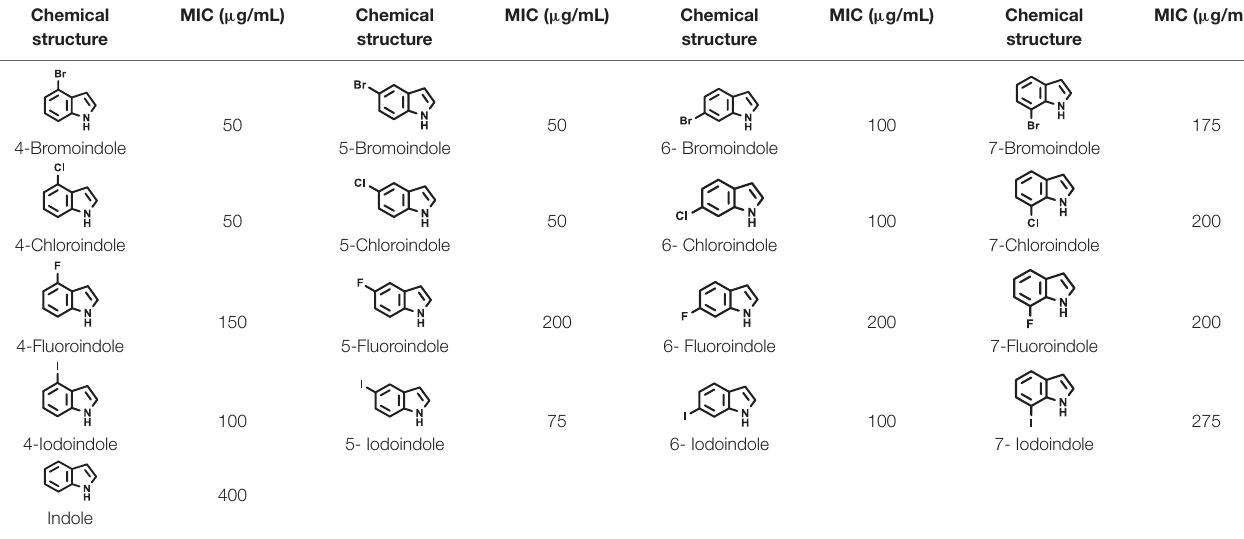
TABLE 1 | Minimum inhibitory concentration (MICs) of the halogenated indoles in V . parahaemolyticus . Chemical